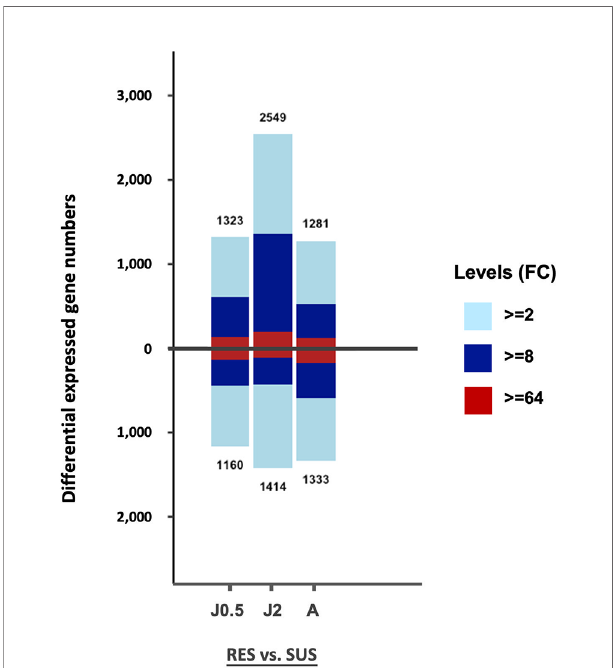
FIGURE 3 | Bar graph showing all DE genes in the six different groups of control snails in Table S2 . On the vertical axis, the number above the bar is the number of genes exhibiting an excess in transcripts in RES compared to SUS, and the number below the bar the number of genes with an excess in transcripts for SUS relative to RES. The three comparisons include RES vs. SUS with juvenile controls @0.5 dpe (J0.5), @2 dpe (J2), and with adult controls @40 dpe (A). The three colors in each bar indicate fold changes (FC) among comparisons: light blue 2-8; dark blue 8-64; and red greater than